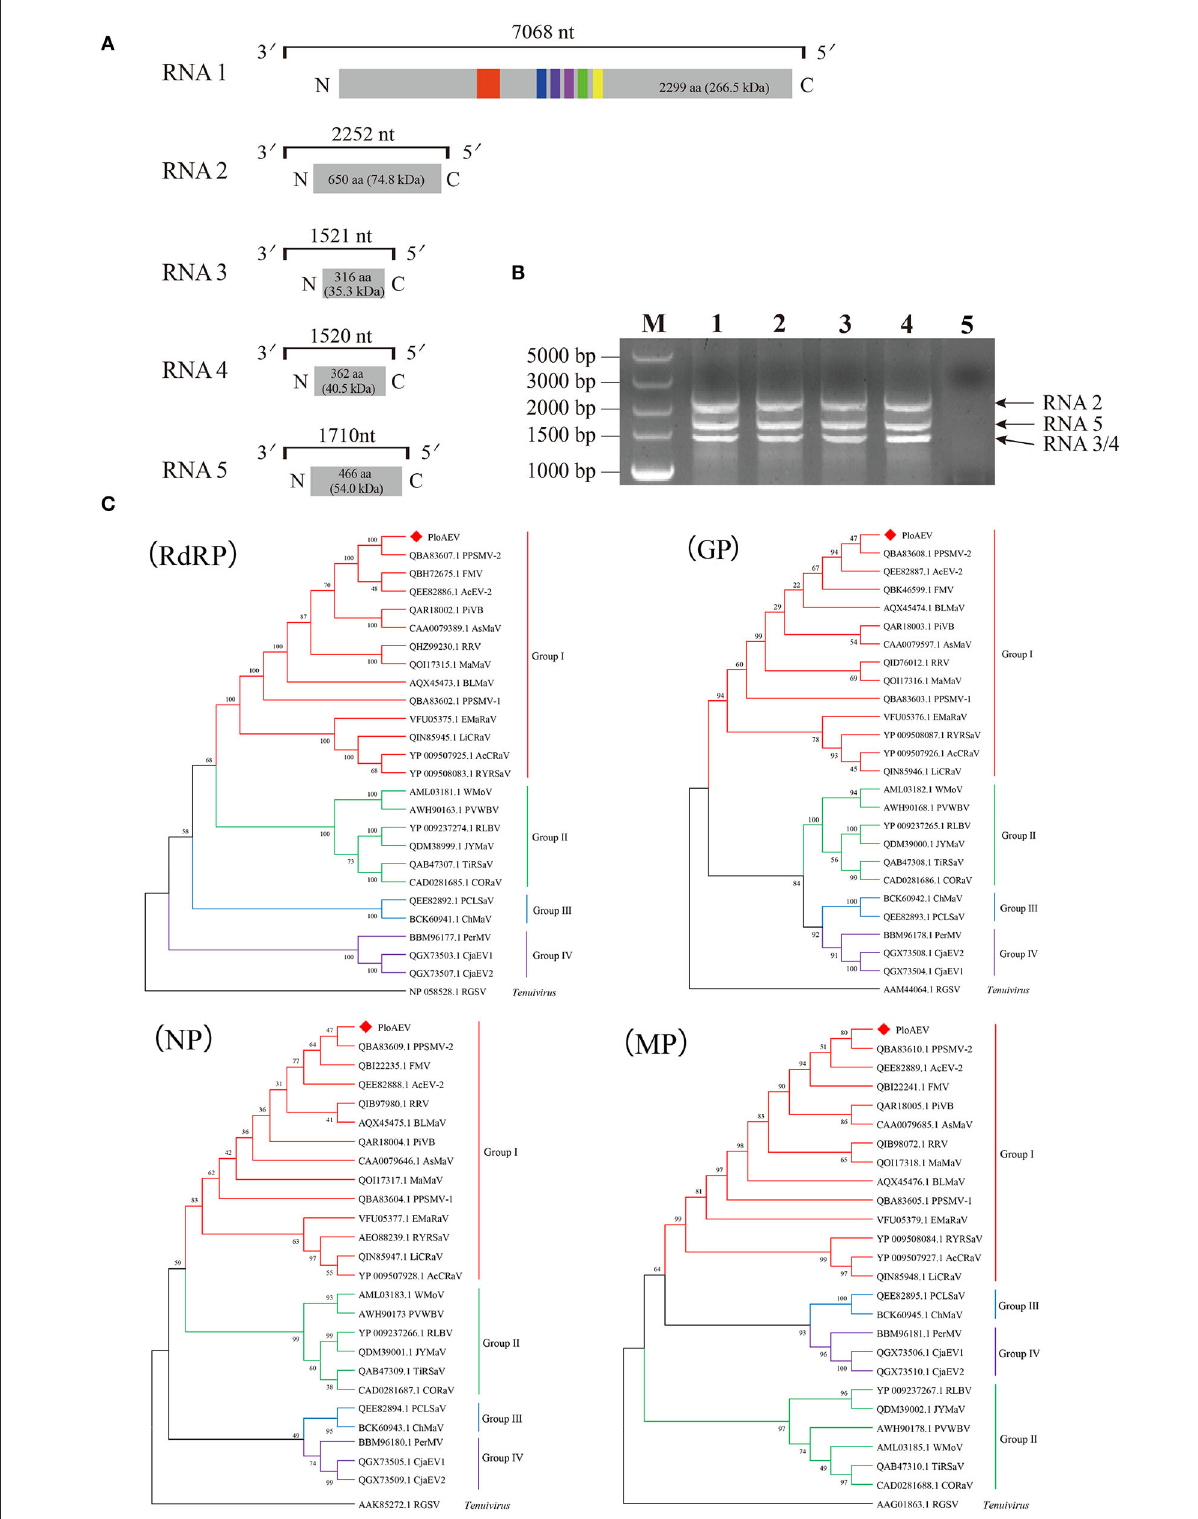
FIGURE2 Genome and phylogenetic analysis of Pueraria lobata -associated emaravirus (PloAEV) identified in P. lobata . (A) Schematic genome organization of PloAEV. Genomic RNAs are displayed as a line, the boxes at whose ends indicate the 13 nts conserved at the RNA termini. Encoded